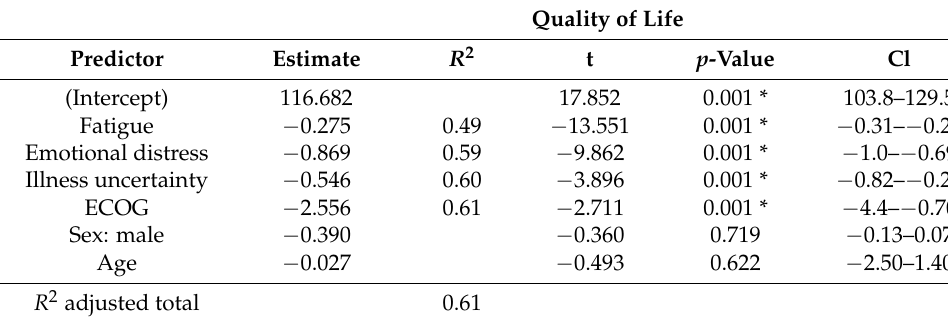
Table 4. Linear regression models probing statistical predictor of